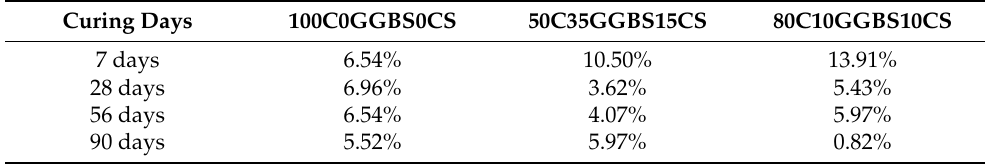
Table 11. Portlandite percent content after 7, 28, 56, and 90 days of